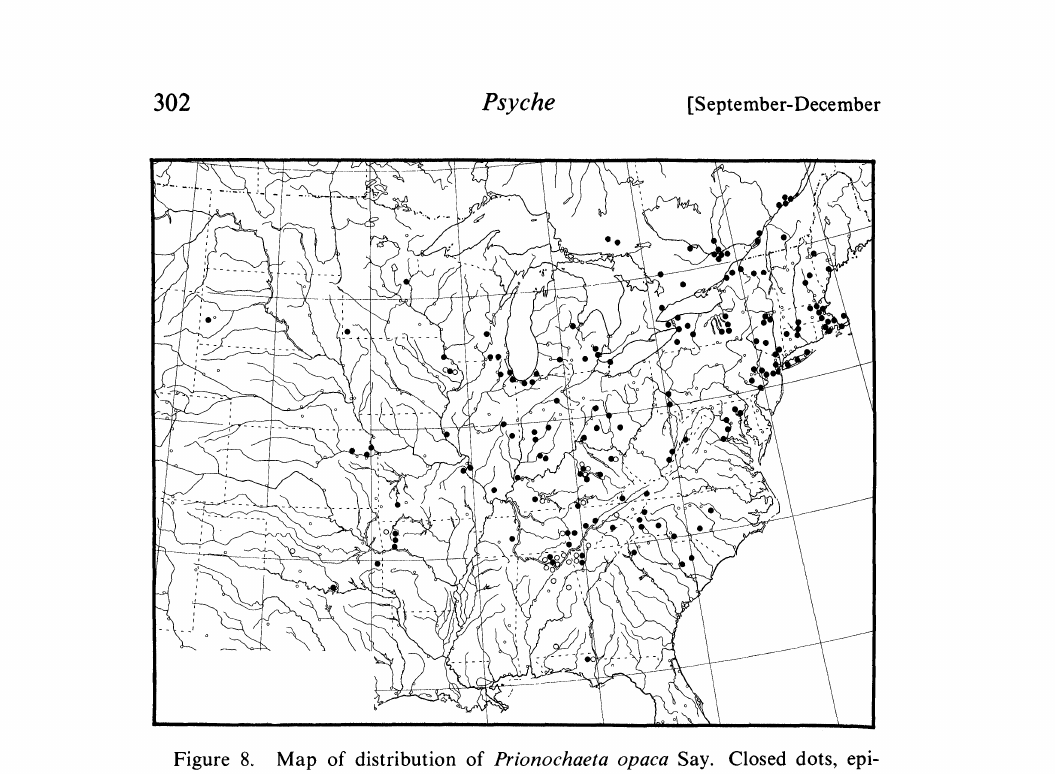
Figure 8. Map of distribution of Prionochaeta opaca Say. Closed dots, epi- gean records. Open dots, cave records. A dot may indicate more than one county locality record. Disjunct forest populations occur in the Black Hills of South Dakota, and in northern Florida. These and the prevalence of cave records in the south indicate adjustment of the species’ range to post-glacial climatic